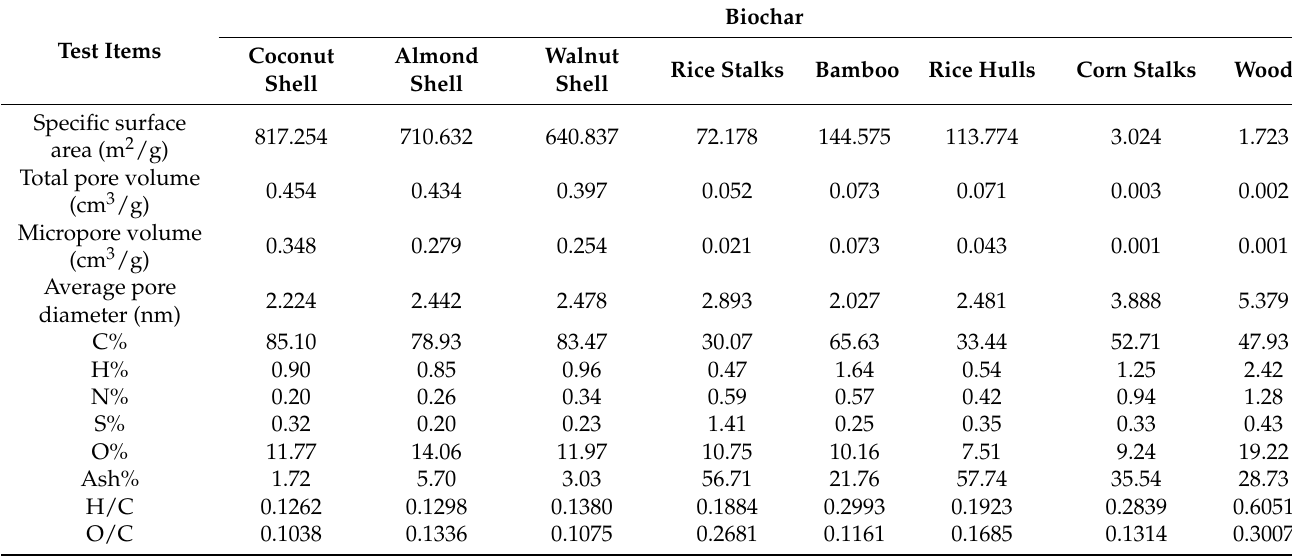
Table 2. Properties of